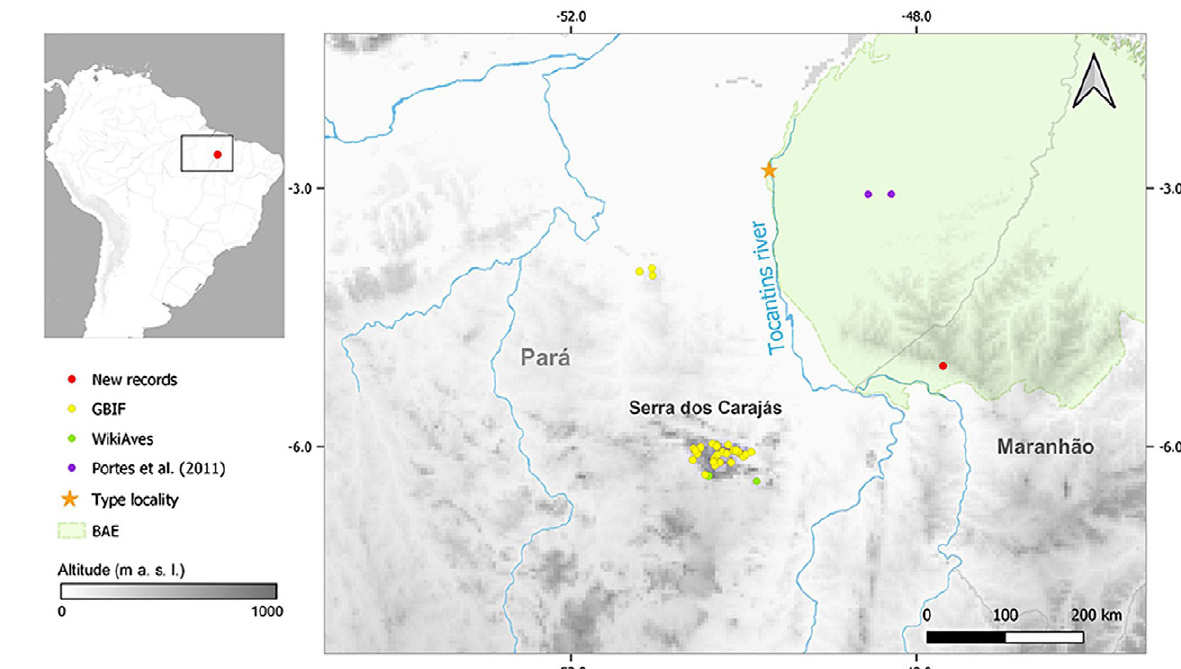
Figure 1. Occurrence records of Oxyruncus cristatus tocantinsi , including the new locality from the Belém Area of